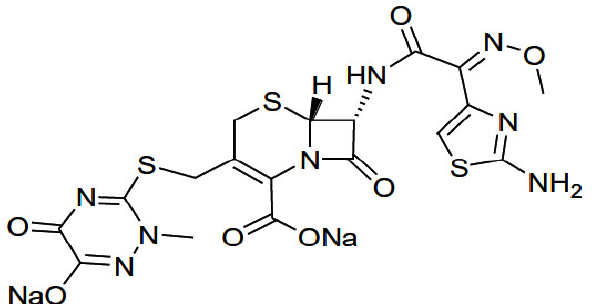
Figure 1. Chemical structure of sodium salt from the antibiotic ceftriaxone drug.